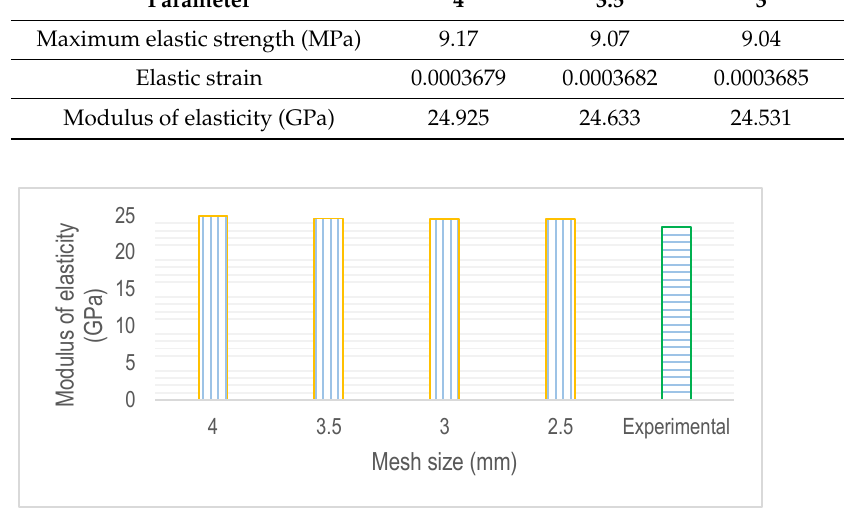
Table 8. Characteristics of the elastic zone.